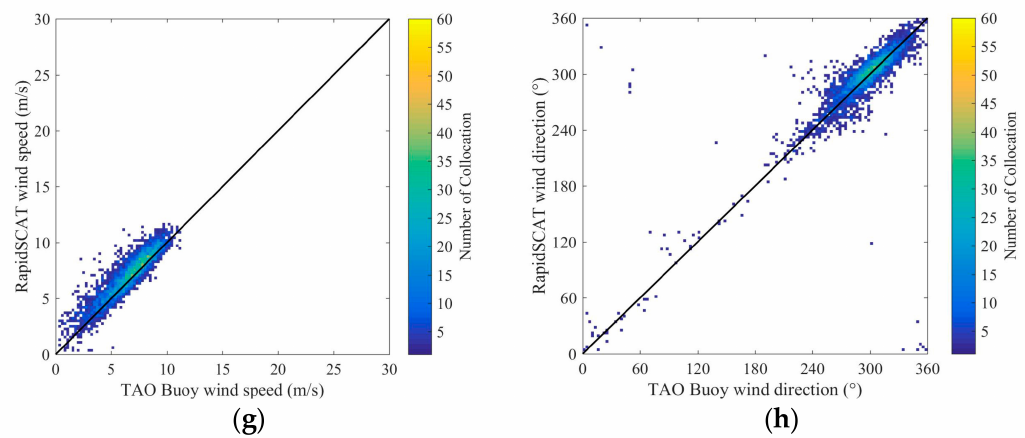
Figure 4. Scatterplots for wind speed and direction of the comparisons between RapidScat and moored buoys. ( a ) NDBC wind speed; ( b ) NDBC wind direction; ( c ) PIRATA wind speed; ( d ) PIRATA wind direction; ( e ) RAMA wind speed; ( f ) RAMA wind direction; ( g ) TAO wind speed; ( h ) TAO wind direction. Table 2. The error statistics of the comparison between the RapidScat and buoy wind data.